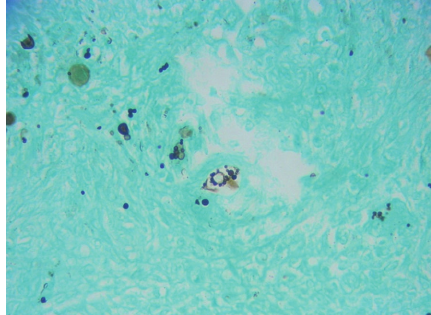
Figure 2: Multiple budding “pilot wheel” morphology of P. brasiliensis (methenamine silver